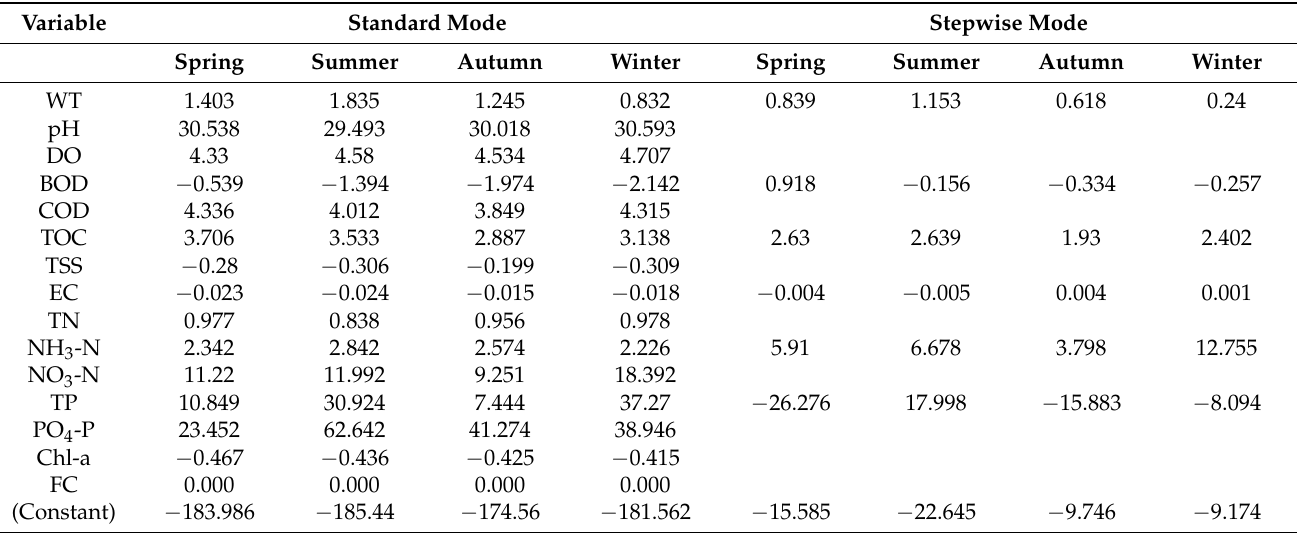
Table 5. Discriminant functions to determine temporal changes (Fisher’s linear discriminant func-